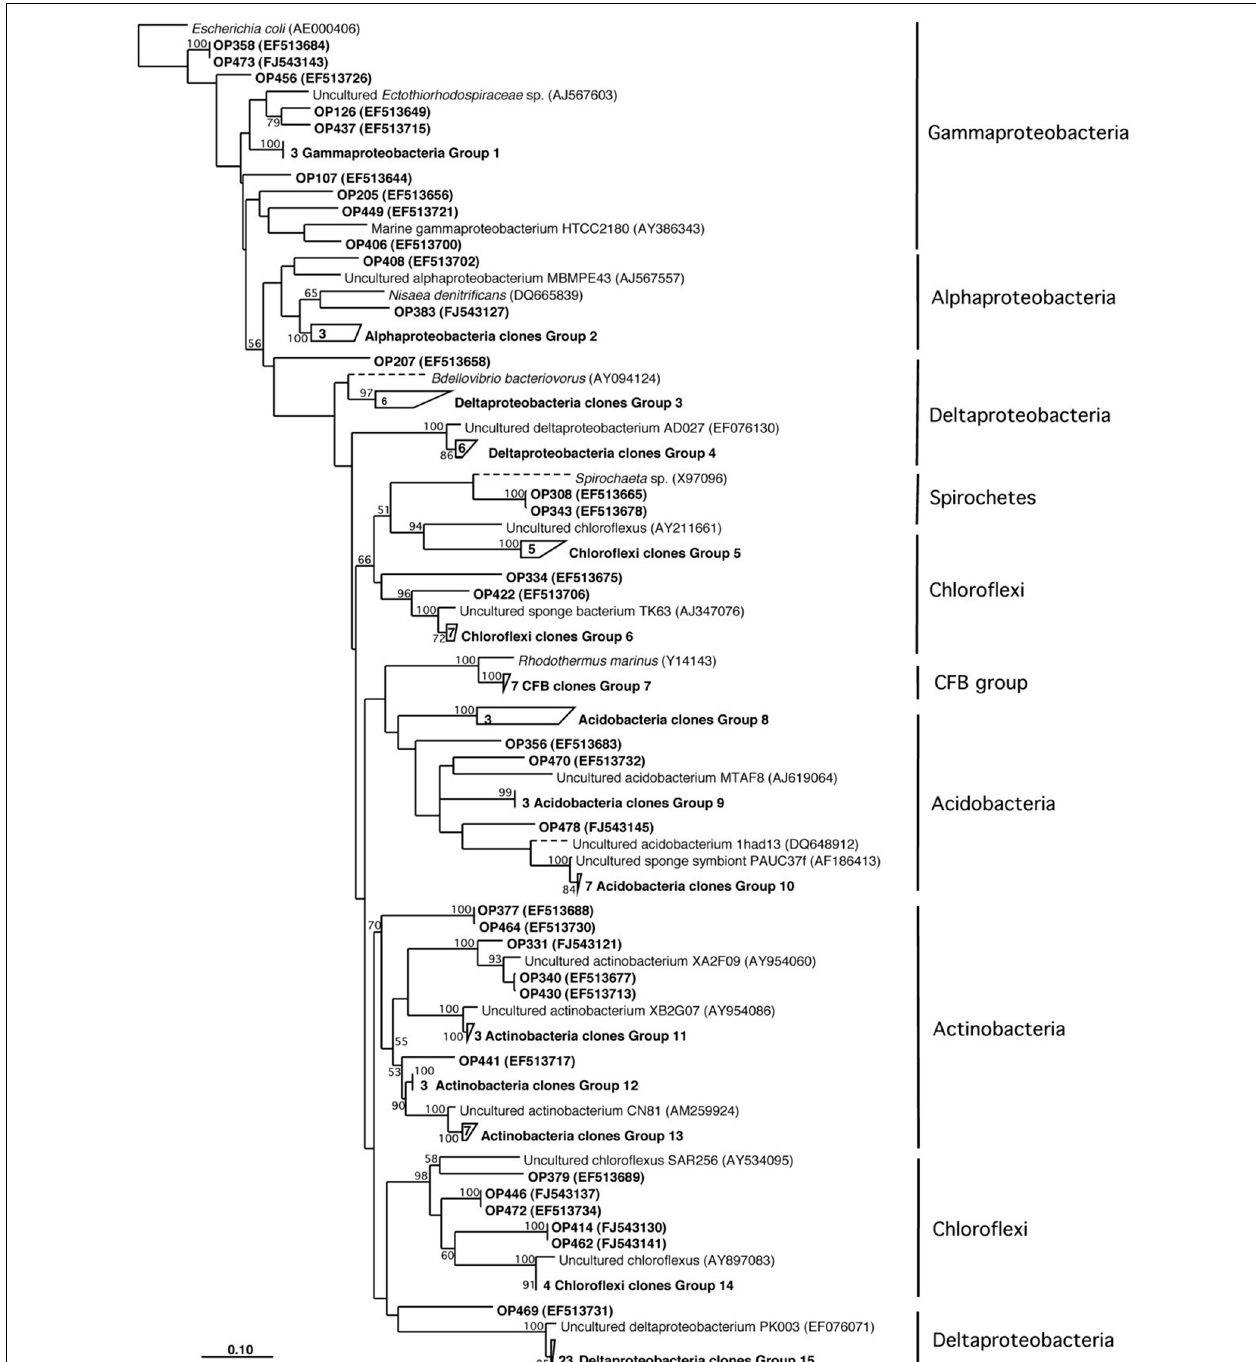
FIGURE 2 | Neighbor-joining phylogenetic tree based on 16S rRNA gene sequence analysis showing the bacterial diversity of Acanthostrongylophora sp.